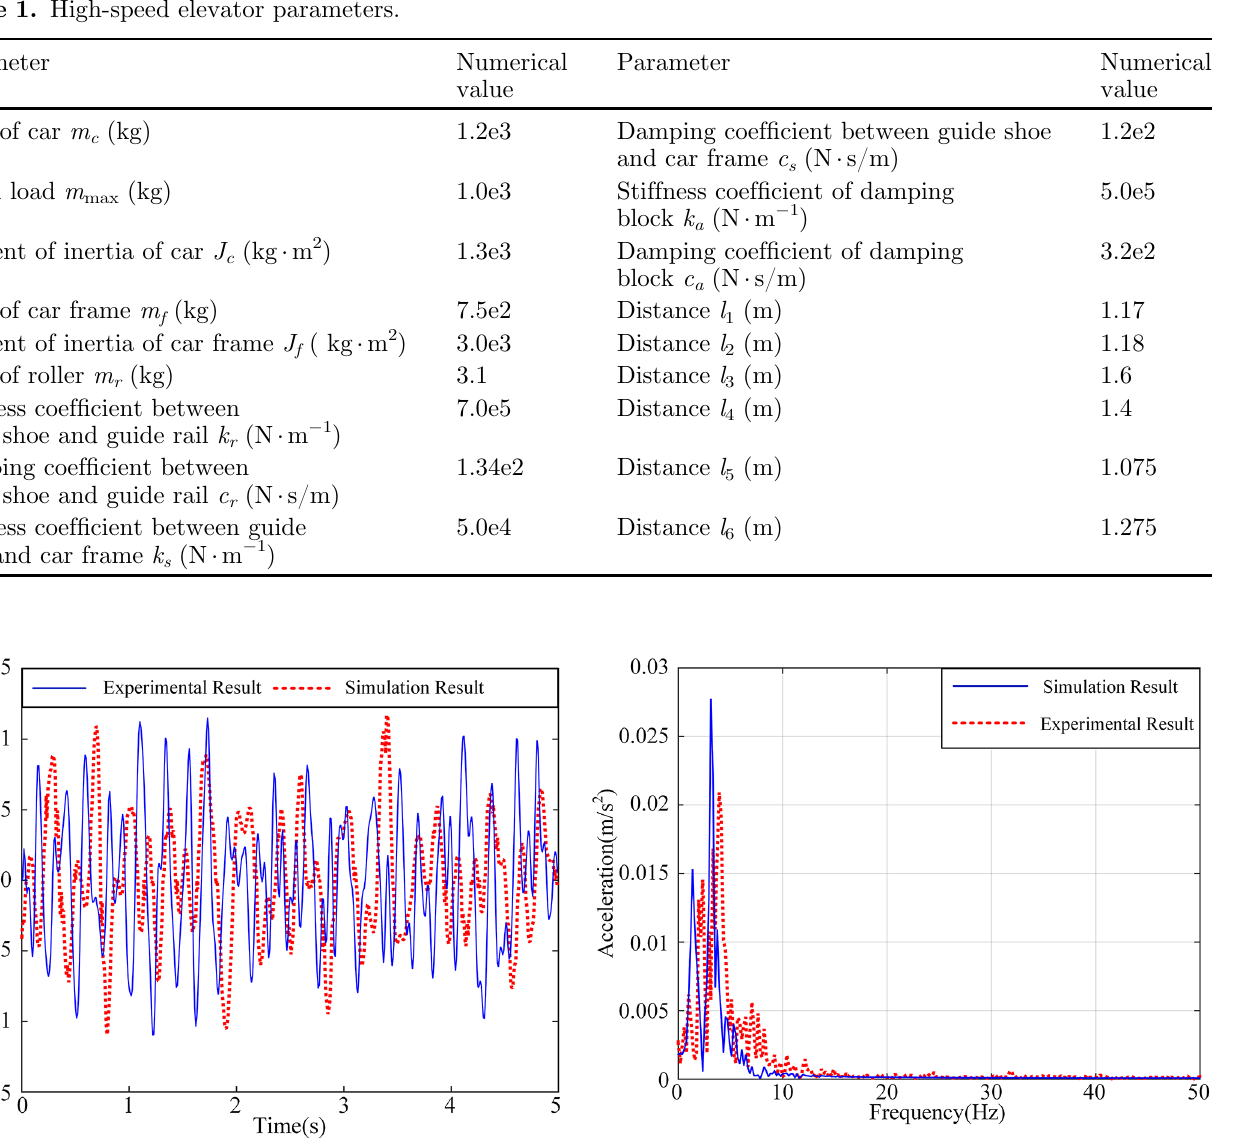
Fig. 12. Frequency-domain diagram contrasting the actual acceleration and the simulated acceleration of the